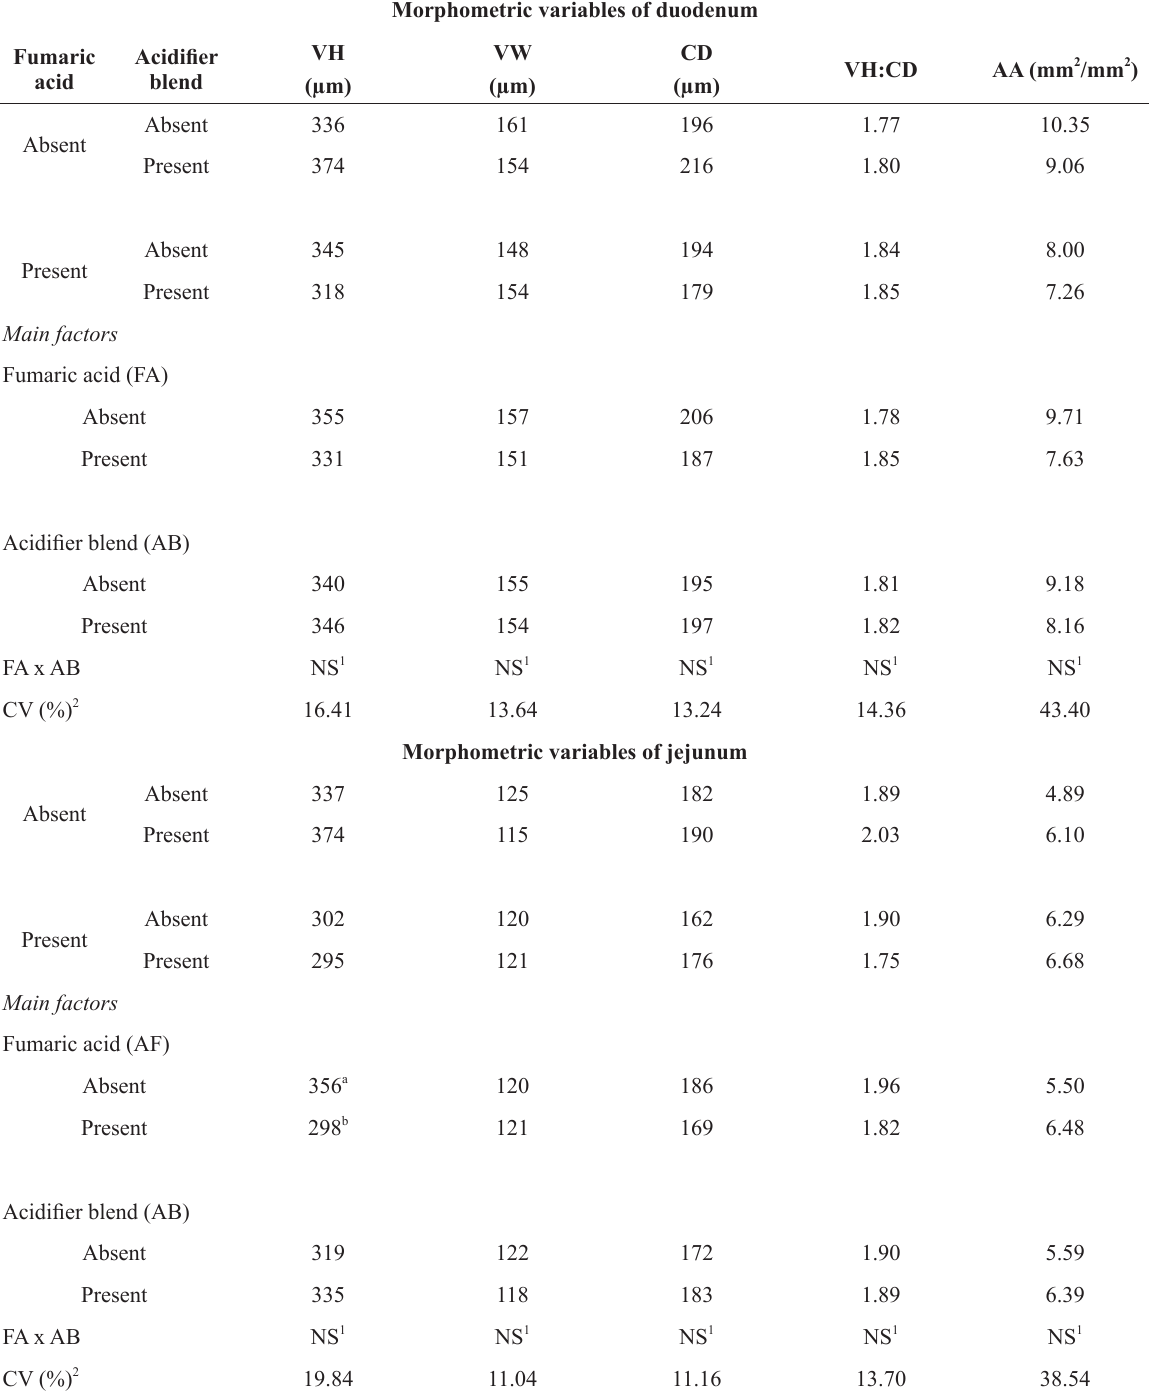
Means of morphometric variables of piglet’s duodenum and